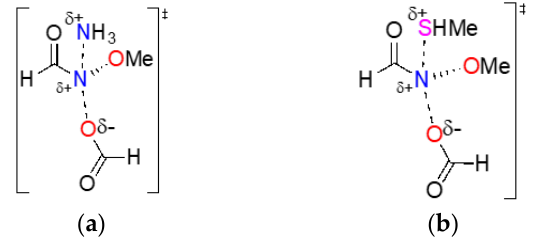
Figure 12. HF/6-31G* predicted charge separation in transition states for reactions of N -formyloxy- N - methoxyformamide with ( a ) ammonia and ( b ) methanethiol.